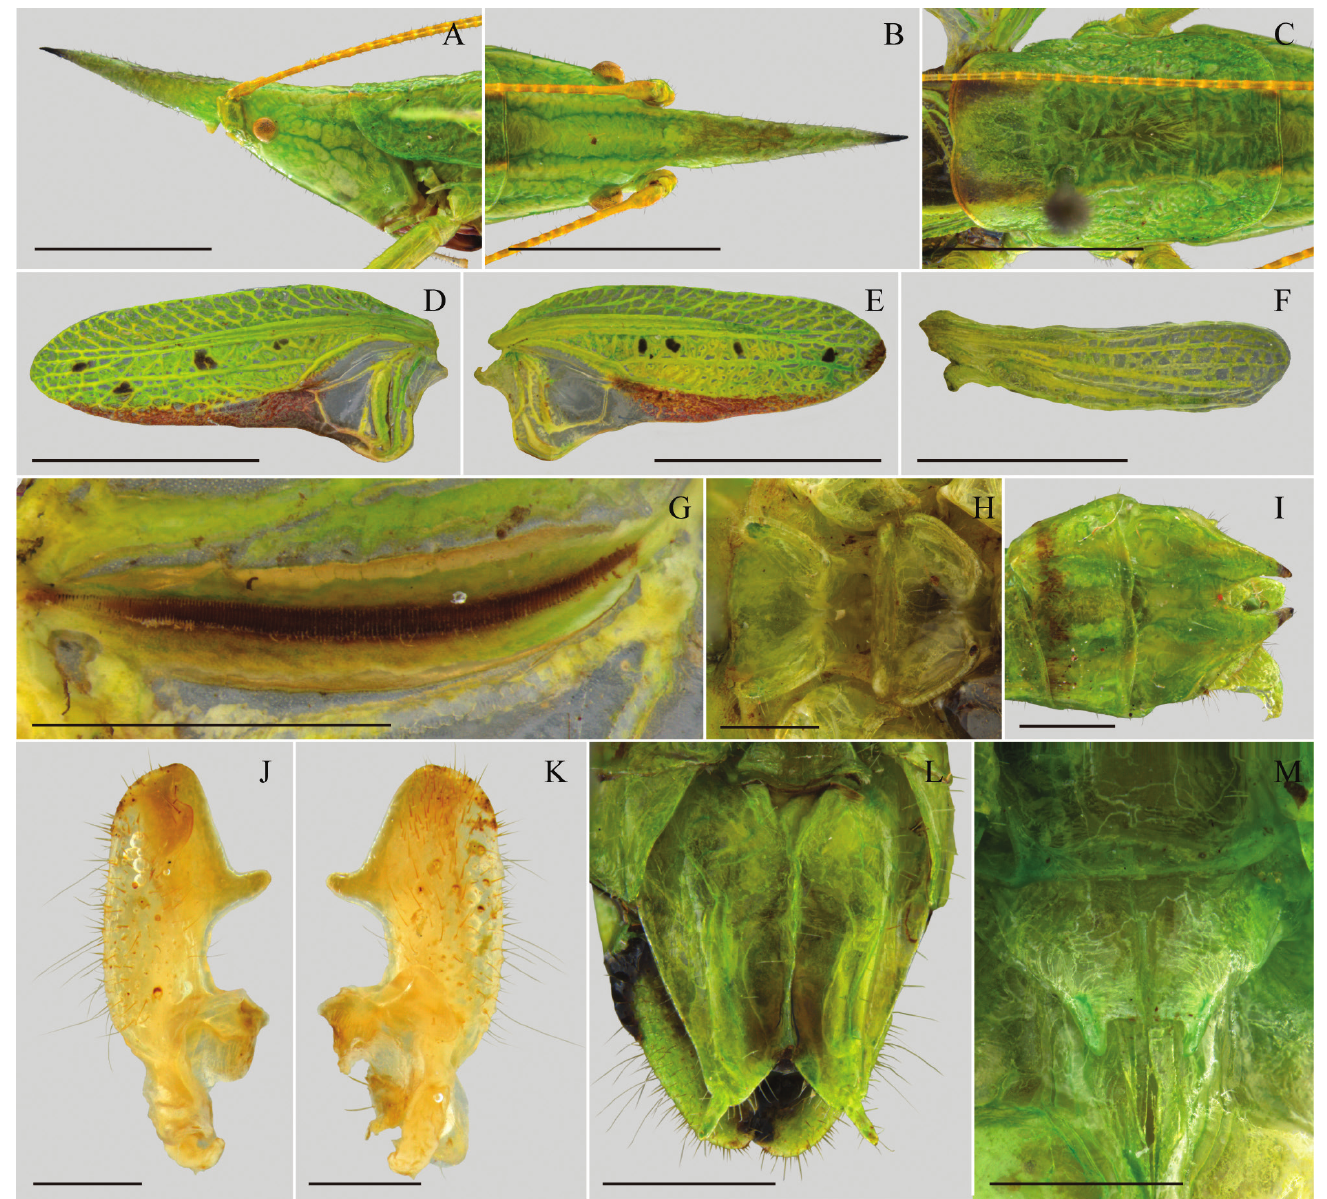
left ( D ) and right tegmen ( E ); F. Posterior wing; G. Stridulatory file (A1 vein); H. Meso and metabasisternum; I. Tergite X; J, K. male